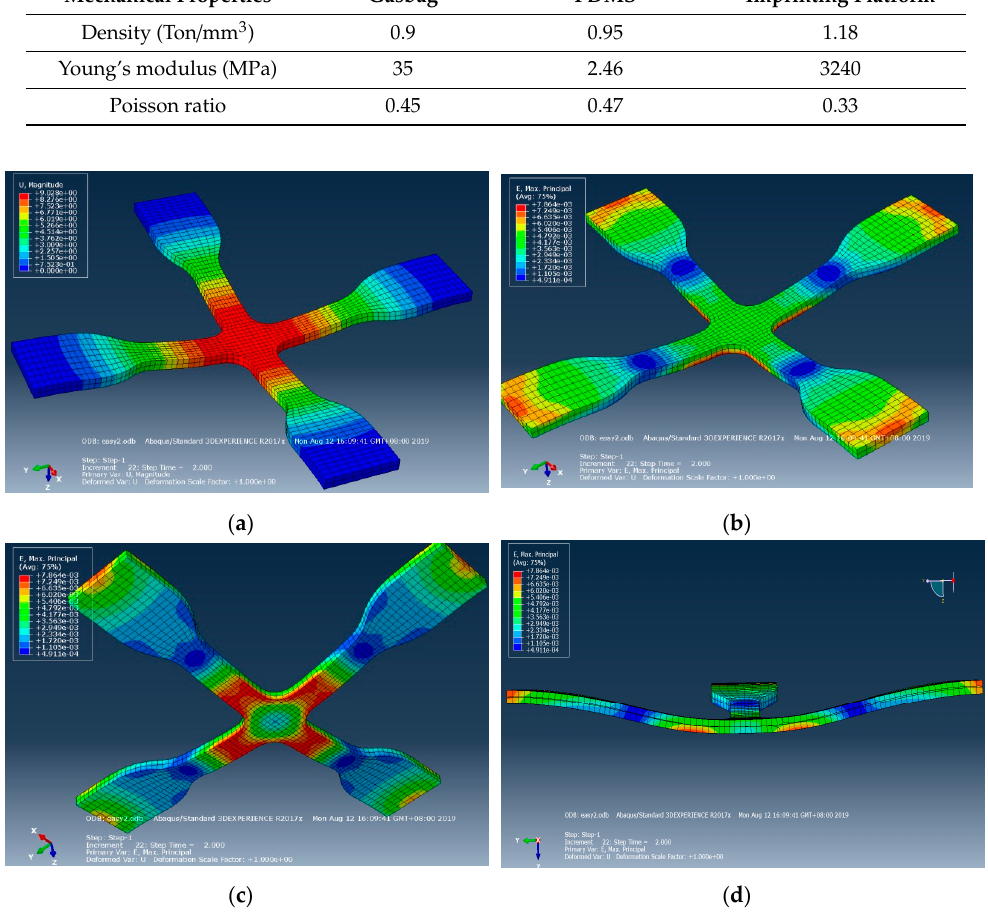
Figure 6. Cross mold contact stress surface, microstructure surface displacement, strain, and cross-section simulation. ( a ) Displacement (stress surface), ( b ) strain (stress surface), ( c ) strain (microstructures surface), ( d ) cross section.